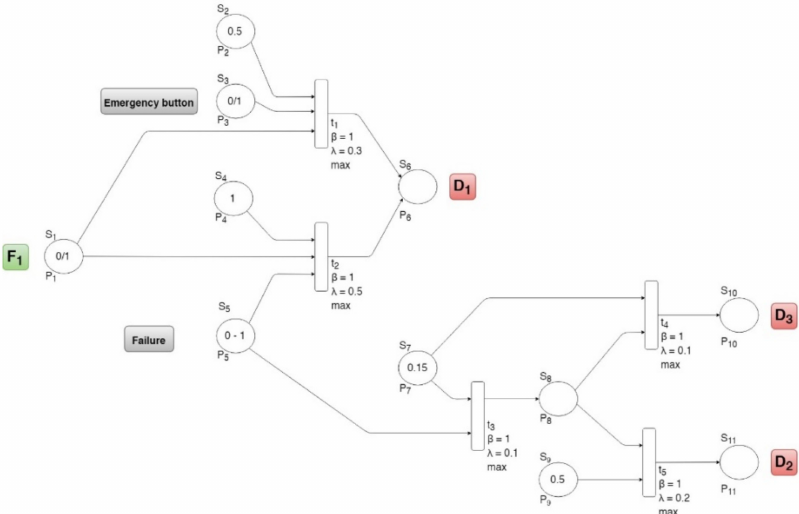
Figure 8. A graphical structure of the fuzzy Petri net algorithm for the transition between the normal production mode (F1) and the different failure modes of the